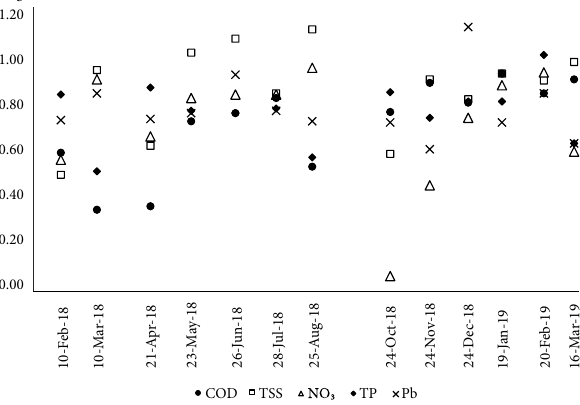
Figure 4. The calculation results of b coefficient